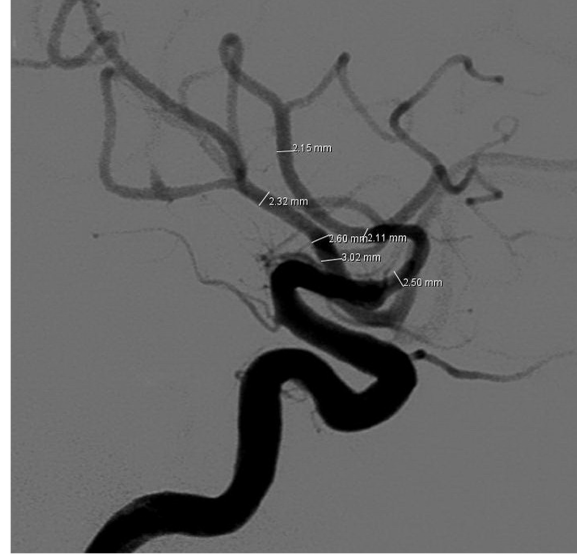
Figure 3. Lateral view measurements in DSA to determine the dominant